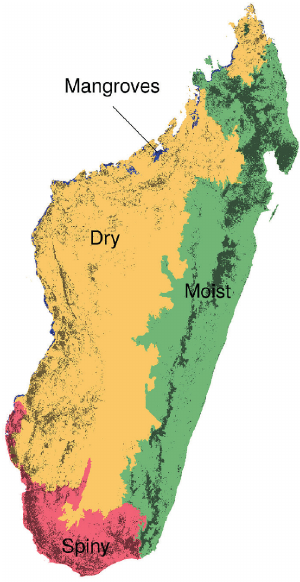
Ecoregions and forest types in Madagascar. Madagascar can be divided into four climatic ecoregions with four forest types: the moist forest in the East (green), the dry forest in the West (orange), the spiny forest in the South (red), and the mangroves on the West coast (blue). The dark areas represent the remaining natural forest cover in 2014. Forest types are defined on the basis of their belonging to one of the four ecoregions. (Reproduced from Vieilledent et al.,